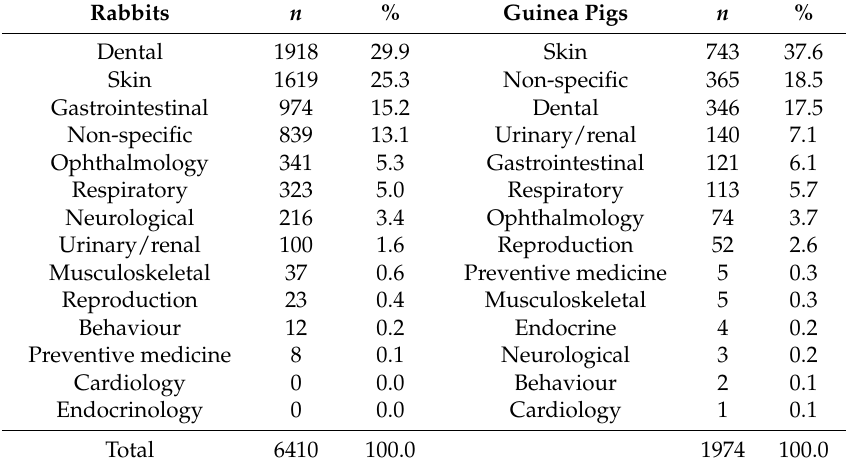
Table 1. Body system categorisation for the conditions or complaints nominated for rabbits ( n = 6410) and guinea pigs ( n = 1974) in a survey of UK veterinarians conducting clinical